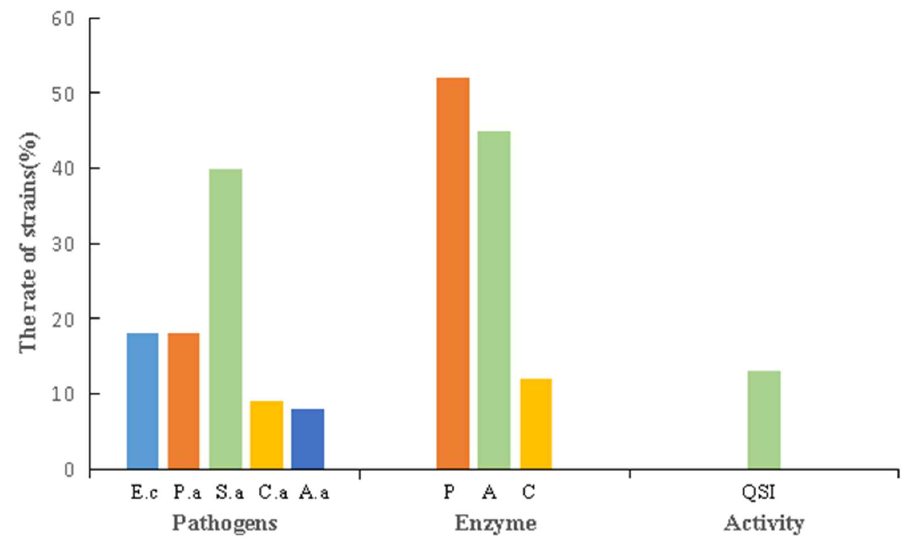
Figure 7. Bioactive potential of actinobacteria (E.c is Escherichia coli ; P.a is Pseudomonas aeruginosa ; S.a is Staphylococcus aureus ; C.a is Candida albicans ; A.a is Alternaria alternata ; P is Protease; A is Amylase; C is Cellulase; QSI is QSI activity).